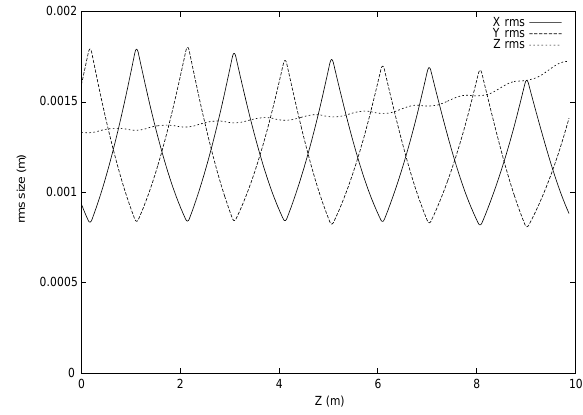
FIG. 2. The rms size of the particles for the reference transport